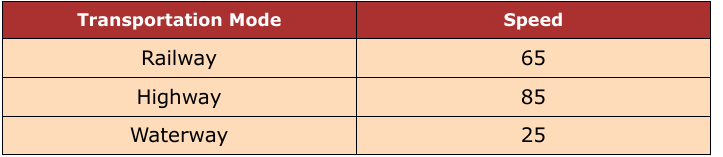
Table 1. Container transportation speeds of the three transportation